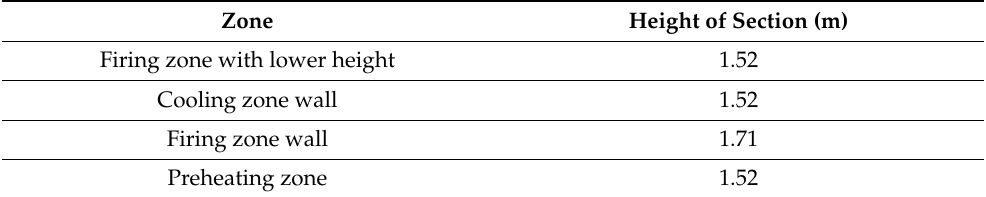
Table 11. Characteristics of the sections for the calculation of thermal losses.